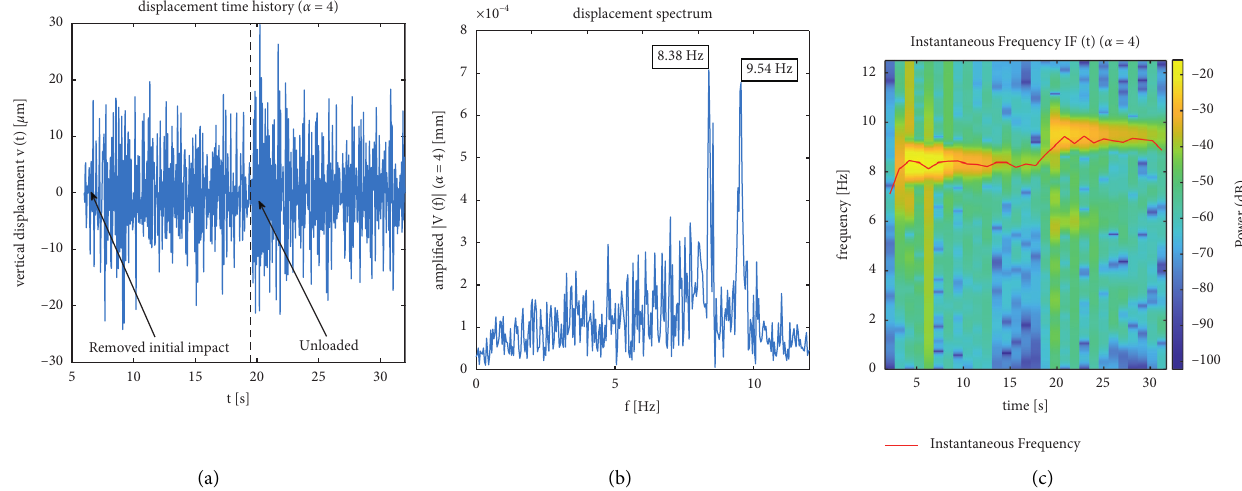
Figure 8: Results from the cantilevered beam (3rd experimental setup, mid-length virtual sensor, α � 4). (a) the extracted time history; (b) the Fourier Transform of the same; (c) the corresponding time-frequency plot and the instantaneous frequency